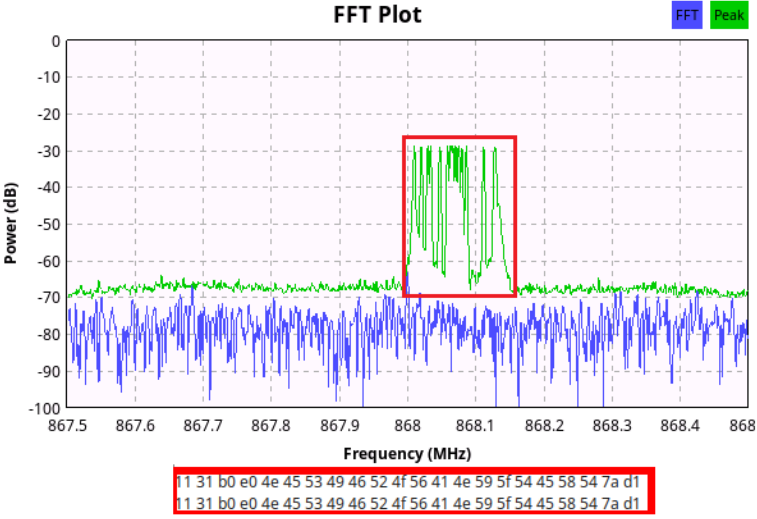
Figure 9. Results of message capture by the